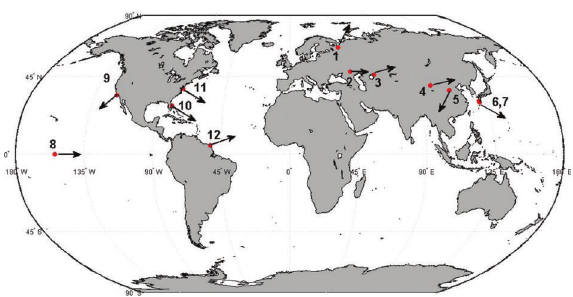
Figure 1: World map locations of main space sites. Arrows indicate the main direction of rocket trajectory after launch. The key world- wide spaceports are as follows: (1) Plesetsk, (2) Kapustin Yar, (3) Baykonur, (4) Jiuquan Space Center, (5) Taiyuan Satellite Launch Center, (6) Tanegashima Space Center, (7) Kagoshima Space Center, (8) Sea Launch, (9) Vandenberg, (10) Cape Canaveral, (11) Wallops space factory, and (12) Centre Spatial Guyanais